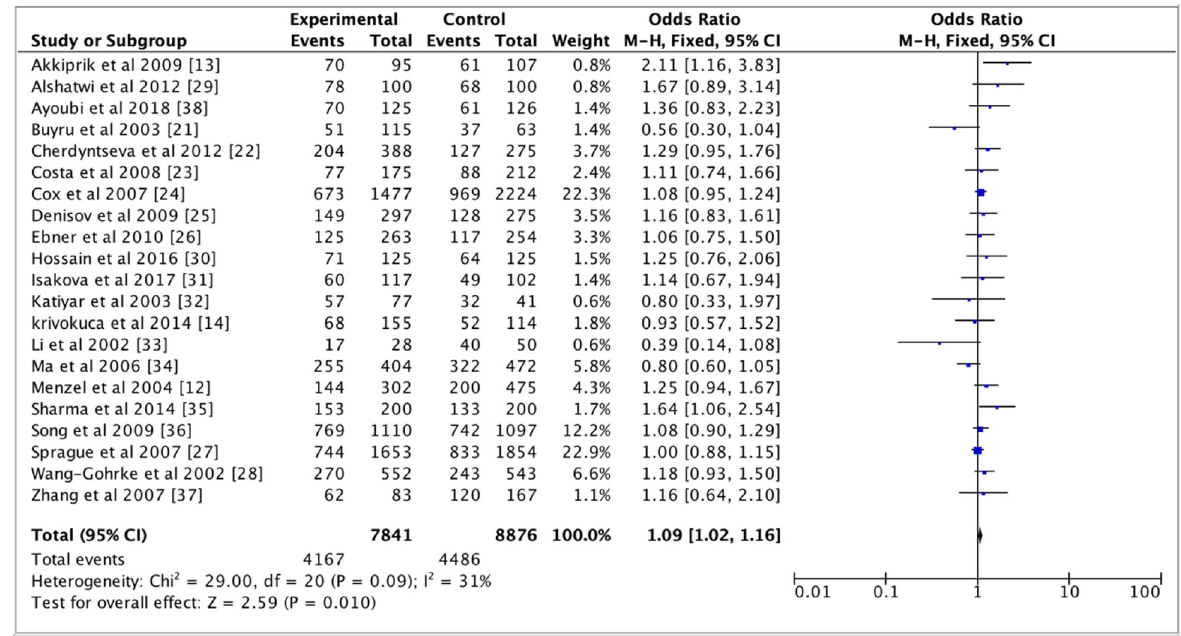
Fig. 2 Forest plots of the association between breast cancer and TP53 p.Arg72Pro polymorphism for the dominant model. The black diamond denotes the pooled OR; blue squares indicate the OR in each study with square sizes inversely proportional to the standard error of the OR; and horizontal lines represent the 95% CI